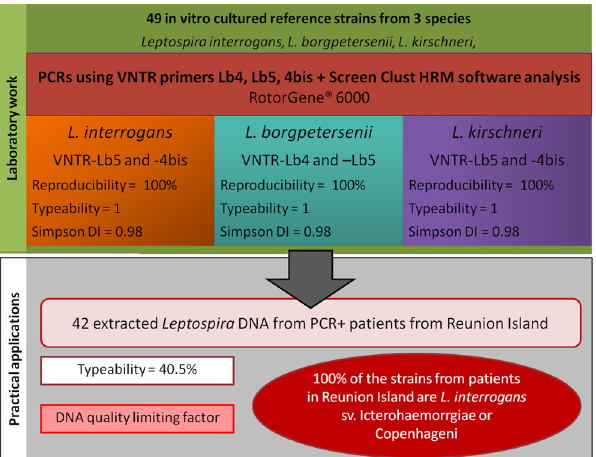
Fig 3. Melting curve analysis of pathogenic Leptospira strains after real-time PCR amplification using the G1/G2 and LFb1F/R primer